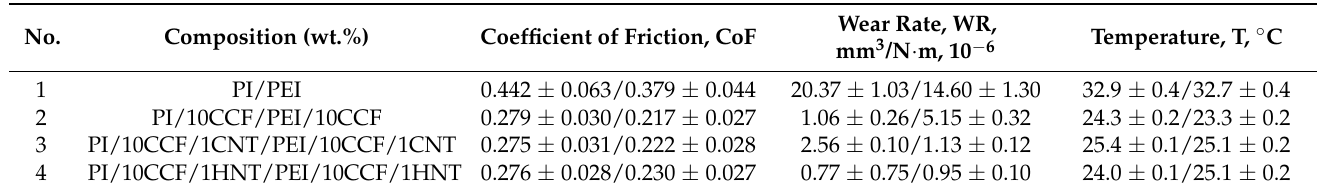
Table 5. The tribological characteristics of neat both PI and PEI, as well as the PI- and PEI-based